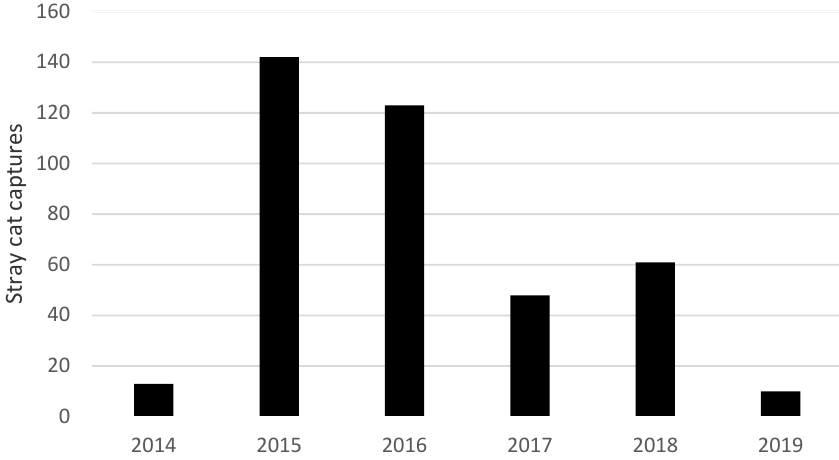
Figure 1. Stray cat captures by Brisbane City Council from Coopers Plains district